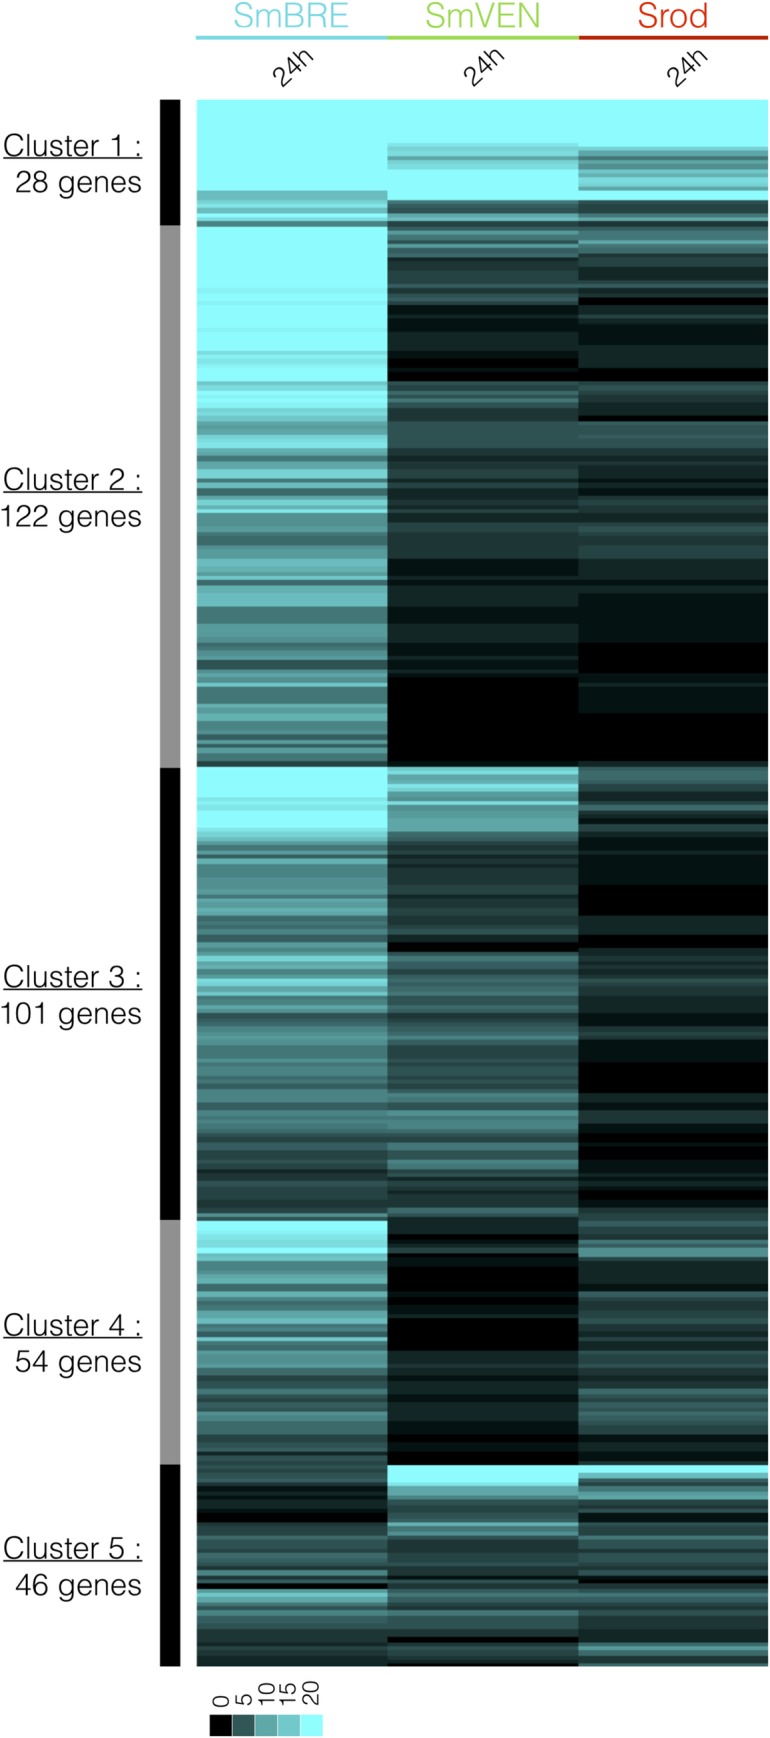
Clustering of intra-molluscalSchistosoma expression patterns.RNAseq library mapping enabled us to identify 351 genes expressed by Schistosoma parasites in Biomphalaria snail tissues. Colors: blue, S. mansoni Brazil (SmBRE); green, S. mansoni Venezuela (SmVEN); and red, S. rodhaini (Srod). The heatmap represents the profiles of the 351 genes expressed by the different parasites at 24 h after infection. Each transcript is represented once and each line represents one transcript. The expression level is highlighted by the different shades of blue.